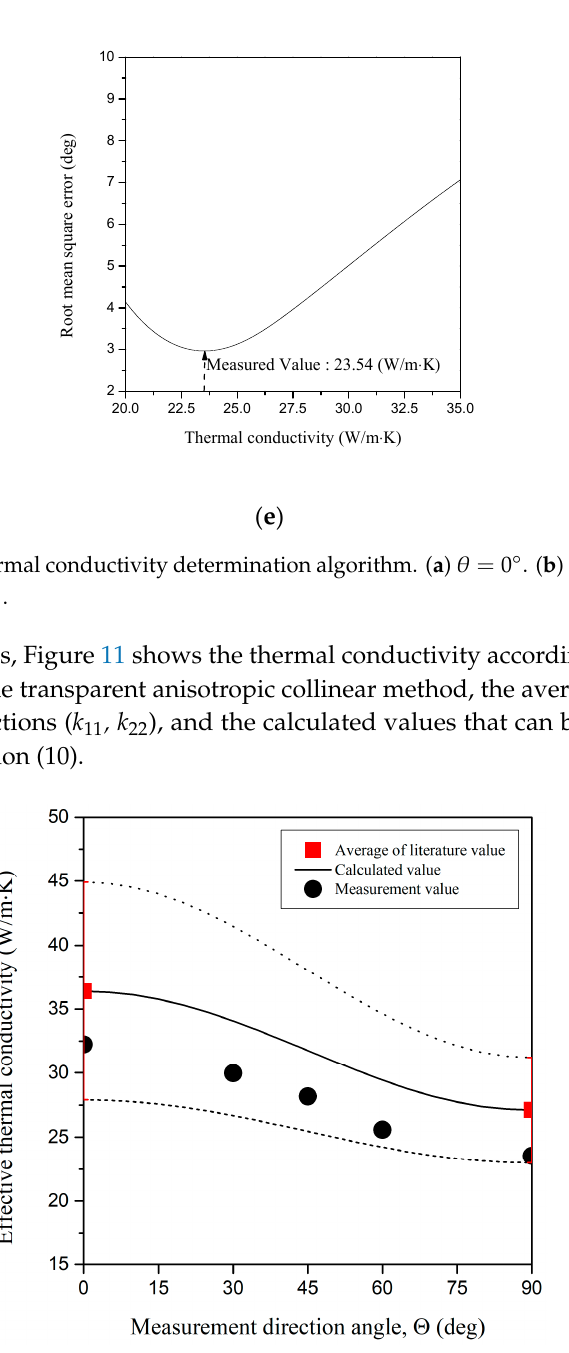
Table 8. Measurement results of A-plane sapphire using collinear deflection method.